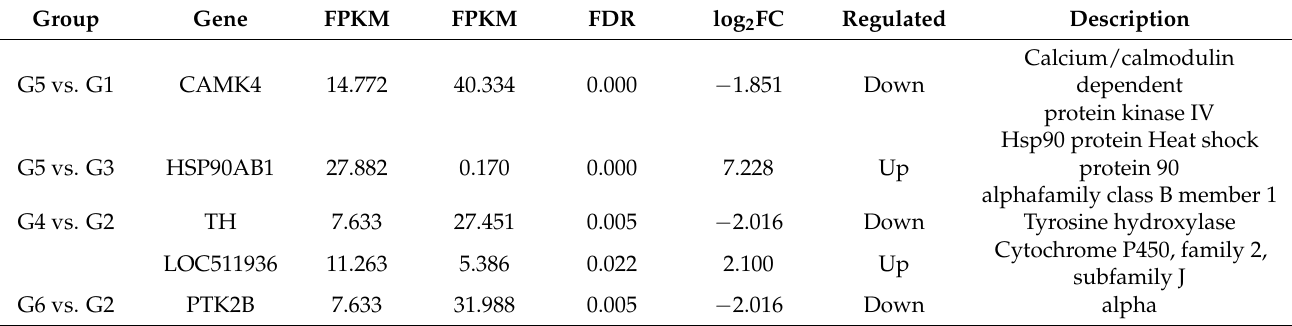
Table 2. Differentially expressed genes related to reproduction (G1, G3, and G5 = 6-month-old, 18-month-old, and 30-month-old Angus cattle pituitary; G2, G4, and G6 = 6-month-old, 18-month-old, and 30-month-old Angus cattle